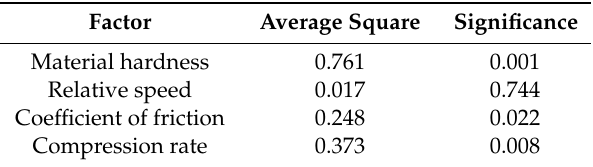
Table 2. ANOVA of maximum resistance.